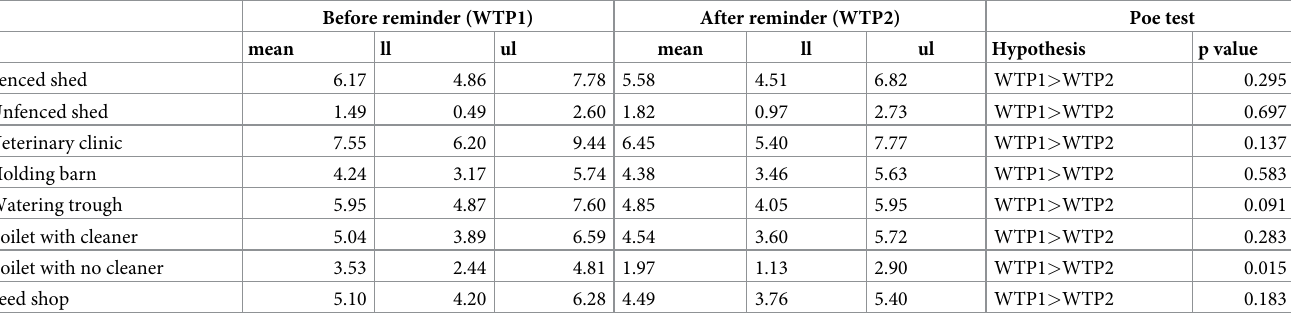
Table 4. Comparing WTP values before and after attention reminder—Poe test